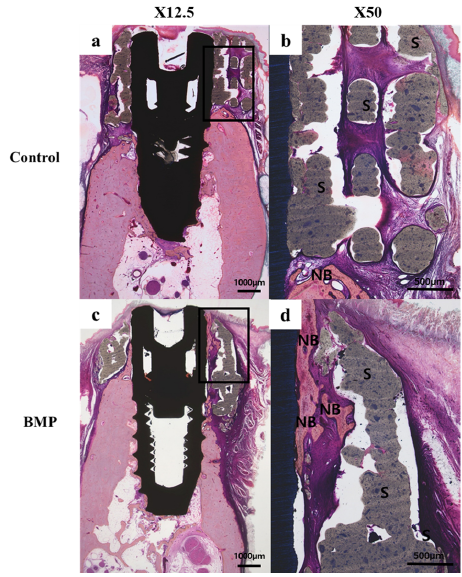
Figure 8. Hematoxylin-eosin stain of the histology sections: ( a , b ) Control group; ( c , d ) BMP group. NB : new bone, S : scaffold (Original magnification: 12.5 × ( a , c ), 50 × ( b , d )).